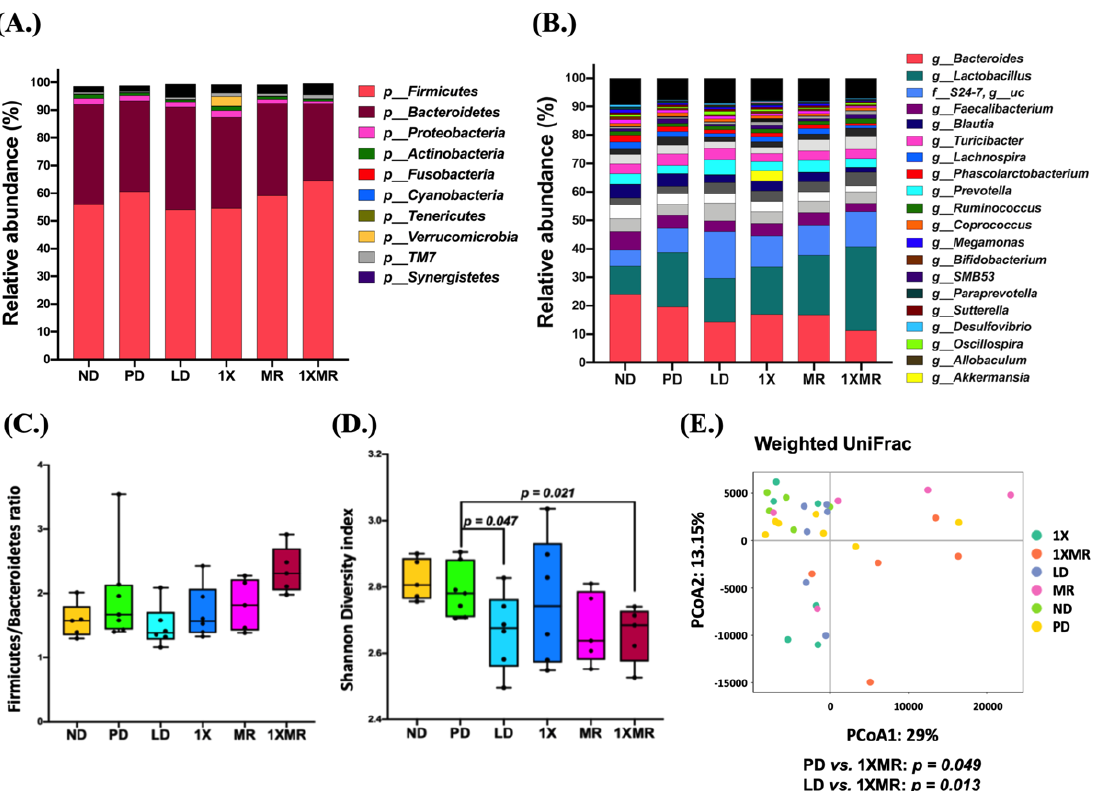
Figure 4. Comparison of bacterial relative abundance and bacterial diversity between groups (n = 5) after 8 weeks of treatment. ( A ) Distribution of the relative abundance of fecal microbiota at the phylum level. Only the top ten most abundant bacteria across all groups are displayed. ( B ) Relative distribution of the abundance of fecal microbiota at the genus level. Only the top 20 most abundant bacteria across all groups are displayed. ( C ) Ratio of Firmicutes to Bacteroidetes in the different groups. ( D ) Analysis of α -diversity based on the Shannon index. ( E ) Analysis of β -diversity using PCoA plots based on the weighted UniFrac metrics of fecal microbiota. ND, non-diseased; PD, untreated PD; LD, PD treated with 8 mg of L-DOPA; 1X, PD supplemented with the probiotic; MR, PD supplemented with MR as prebiotic; 1XMR, PD supplemented with a combination of 1X and MR.